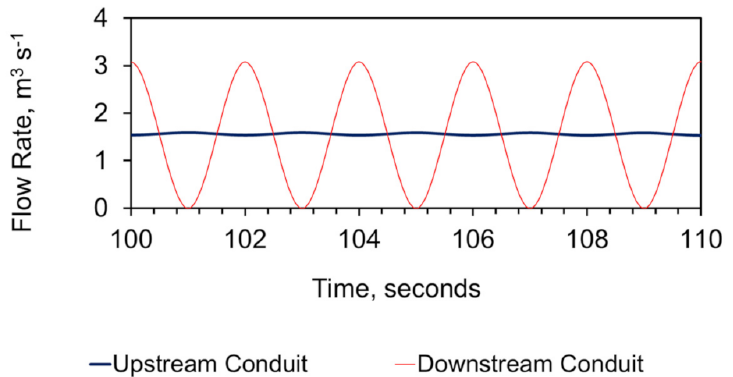
Figure 3. Example wave structuring created by an EPB, where the USA receives a constant gas flow rate through the upstream conduit and the gas is discharged in pulses from the USA to the DSA via the EPB. This results in a pulsed gas outflow through the downstream conduit from the